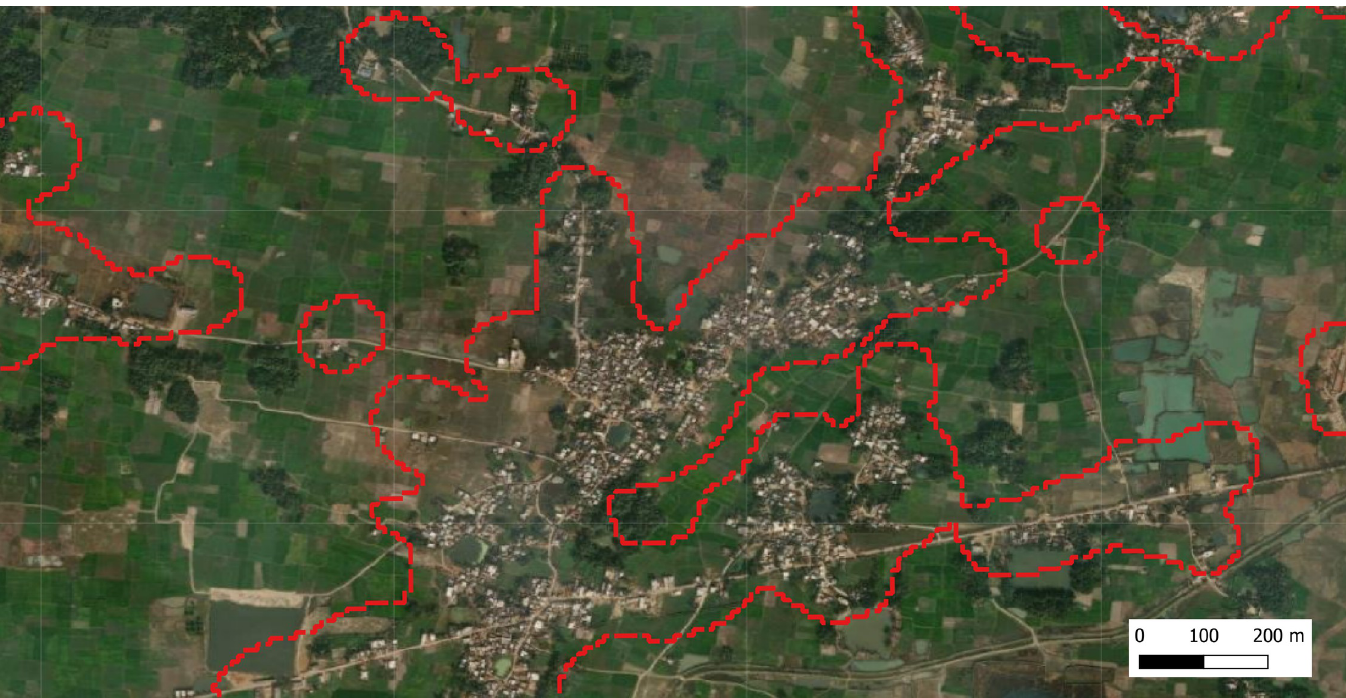
Fig 1. Tola’s outlined shown against EarthExplorer background. We used United States Geological Survey (USGS) Map as a base layer for this map (http://www.usgs. gov).